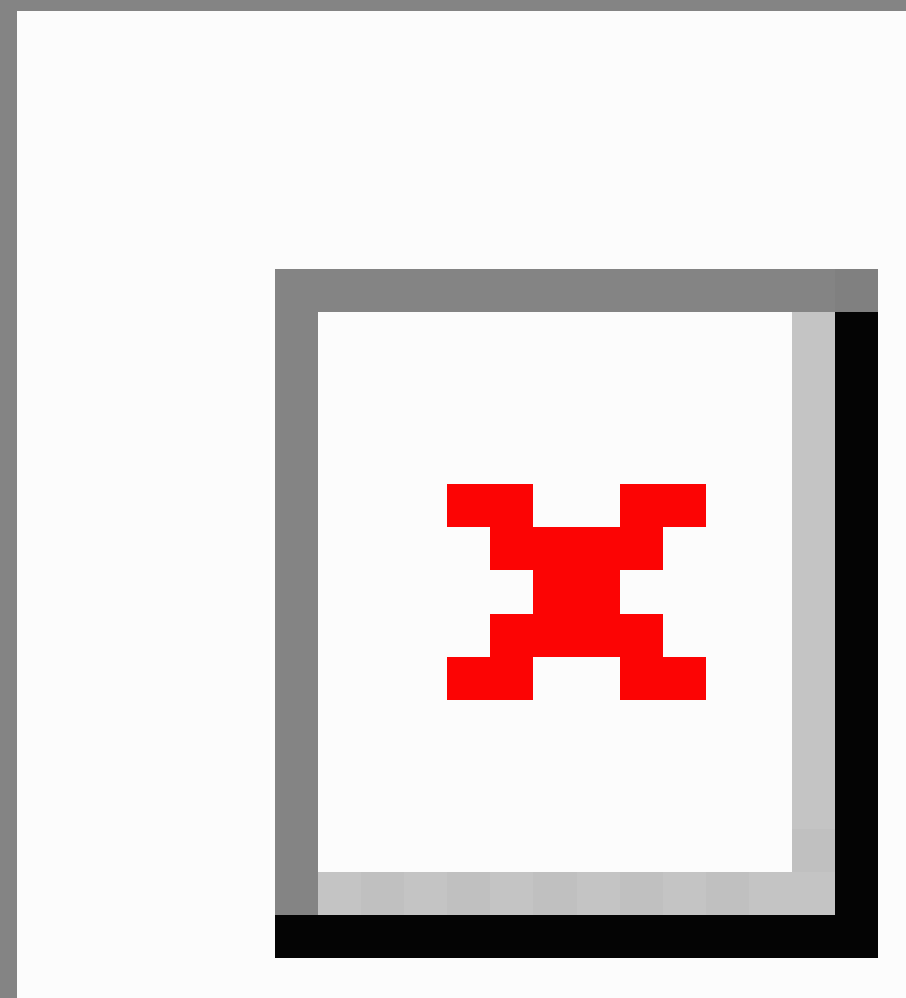
Figure 3. The distribution of on-demand tips accessed over